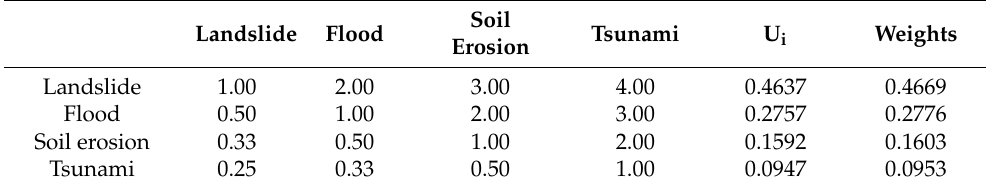
Table 10. Assigned values and comparison between all hazards. Ui depicts the geometric mean of normalized values of each